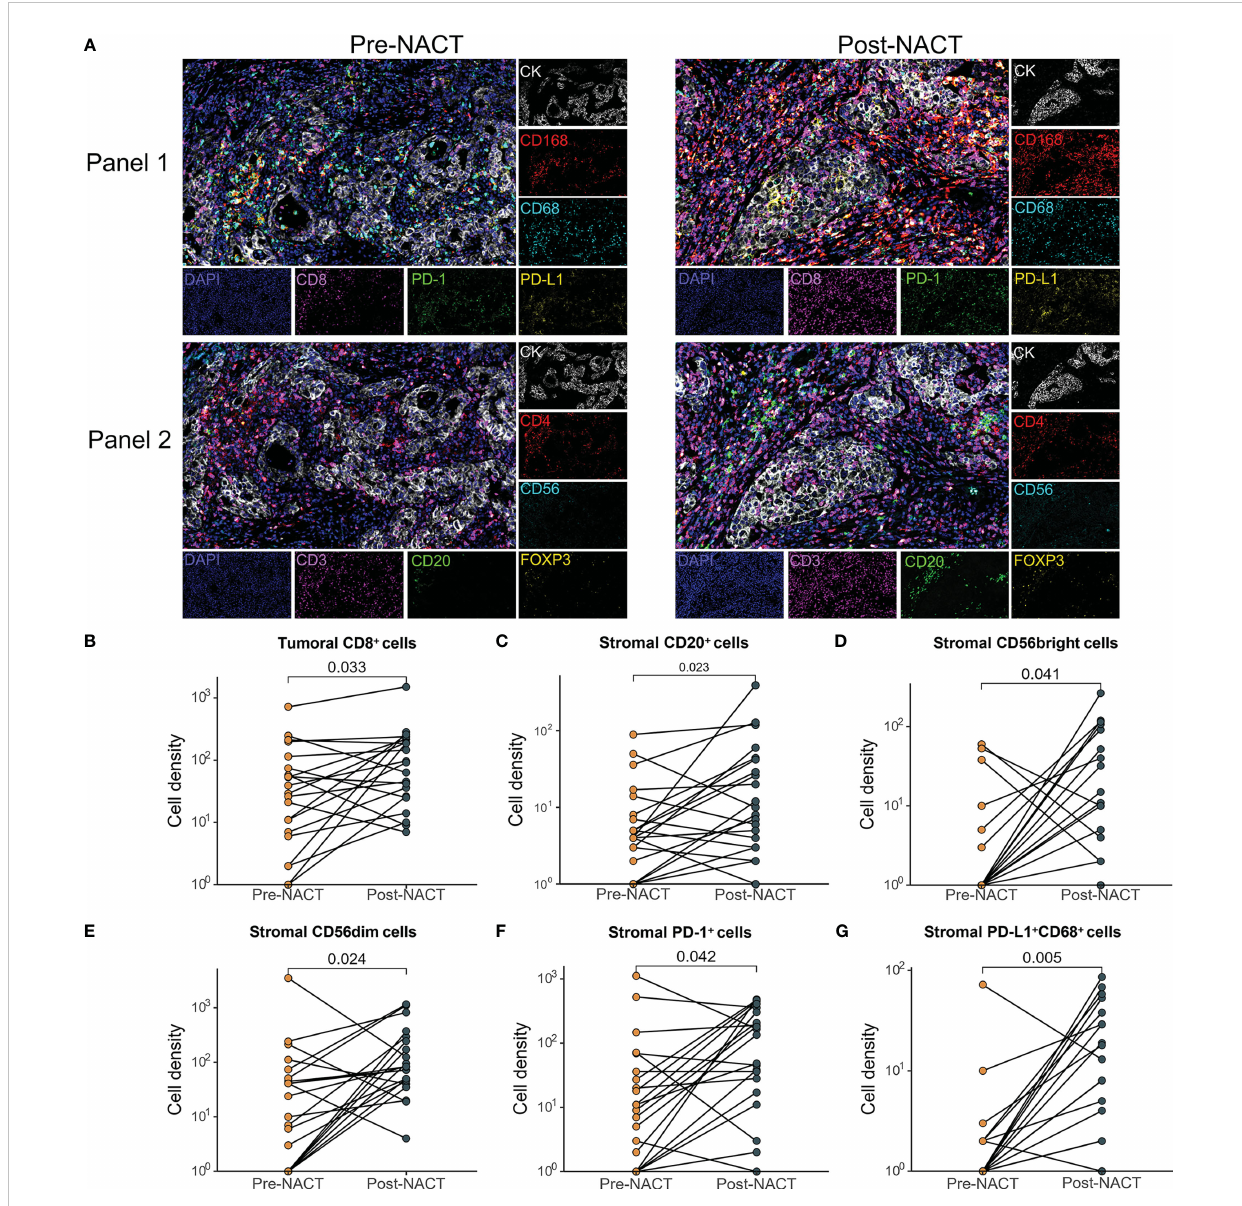
FIGURE 1 Comparison of changes in the tumor immune microenvironment between pre- and post-NACT matched tumor samples (n=21). (A) Images of representative mIF results. Pre-NACT mIF image on left, post-NACT mIF image on right. (B – G) Comparison of density of (B) tumoral CD8 + cell; (C) stromal CD20 + cell; (D) stromal CD56bright cell; (E) stromal CD56dim cell; (F) stromal PD-1 + cell; (G) stromal PD-L1 + CD68 + cells between pre- and post-NACT tumor samples. P value, Wilcoxon matched-paired signed-ranked test for paired